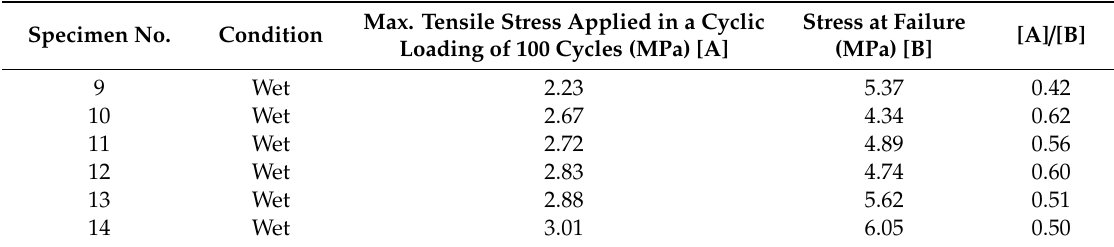
Table 4. Cyclic load results for specimens 9 to 14.